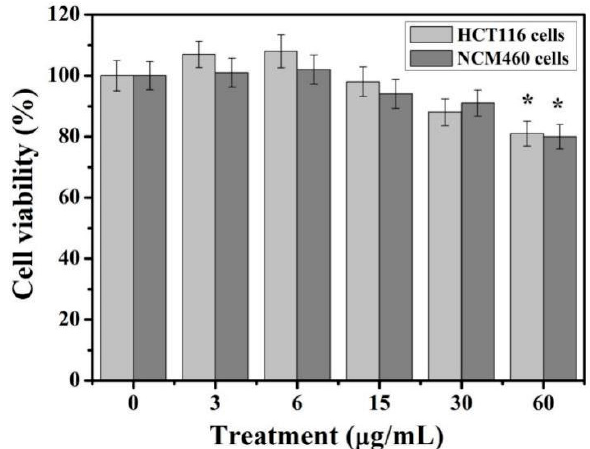
Figure 2. Cytotoxicity of TiO 2 -NPs against HCT116 and NCM460 cell lines. The experiments were carried out in triplicate and data presented are in mean values. * indicates p < 0.05.